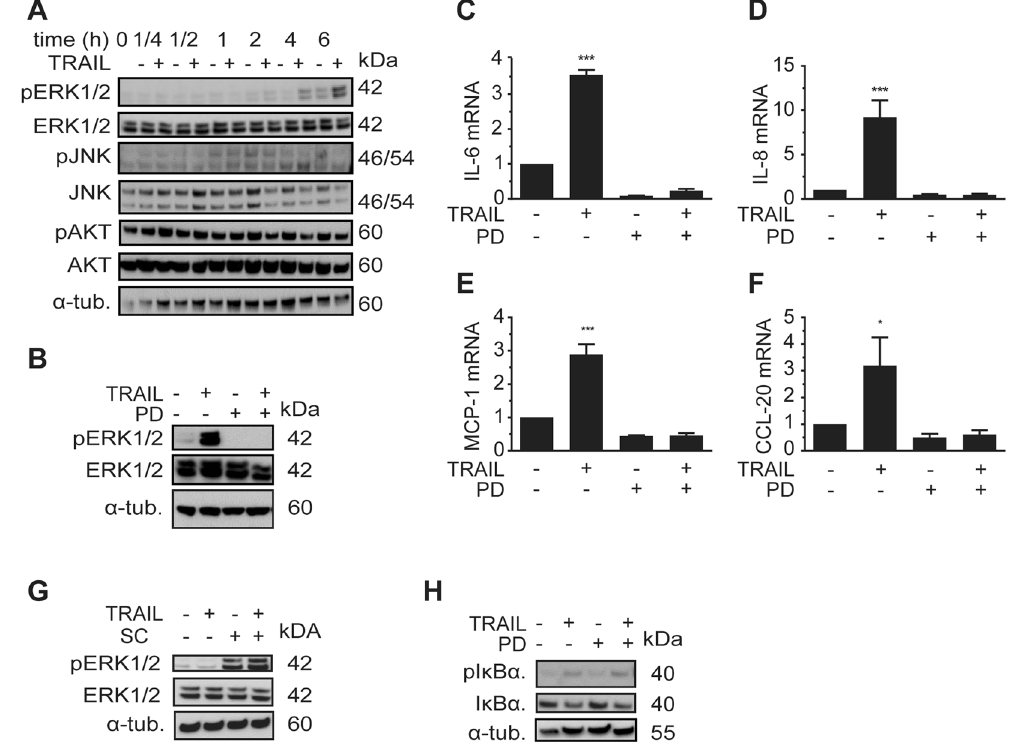
Figure 6. TRAIL induces the phosphorylation of ERK1/2. ( A ) SGBS adipocytes on day 14 of adipogenic differentiation were treated with TRAIL (30 ng/ml) or vehicle and protein was isolated at different timepoints (1/4, 1/2, 1, 2 and 6 hours). The phosphorylation of ERK1/2, JNK and AKT was determined by Western blot. ( B – F ) SGBS adipocytes on day 14 of adipogenic differentiation were treated with TRAIL (30 ng/ml) or vehicle in the absence or presence of the MEK1/2 inhibitor PD-0325901 (100 nM). After 6 hours, the phosphorylation of ERK1/2 and I κ B α was analyzed by Western blot ( B ). α -tubulin was used as a loading control.